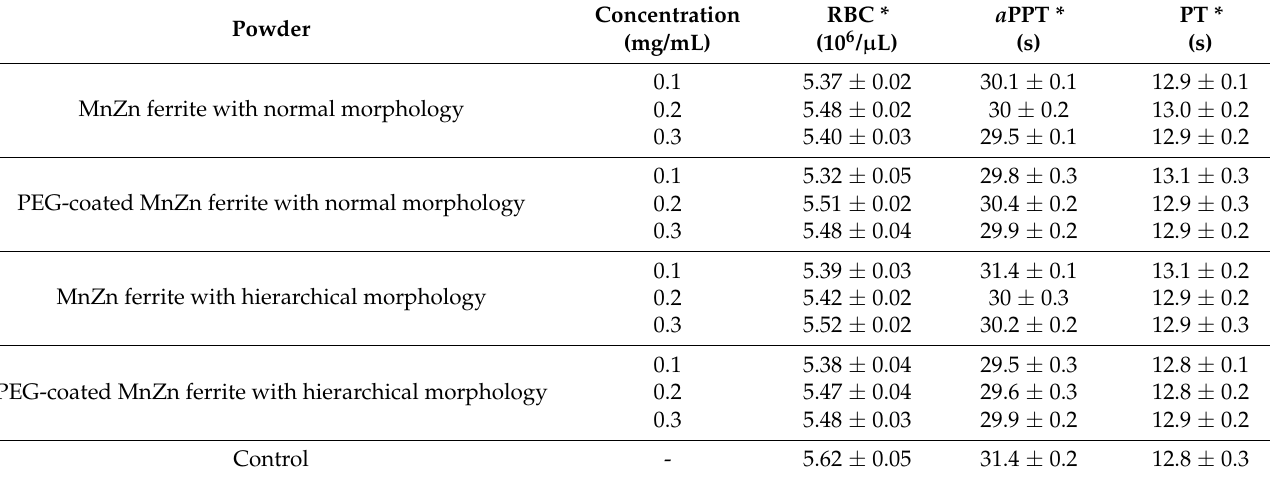
Table 2. Effect of concentration and morphology of MnZn ferrite nanoparticles on values of RBC, a PPT, and PT of blood